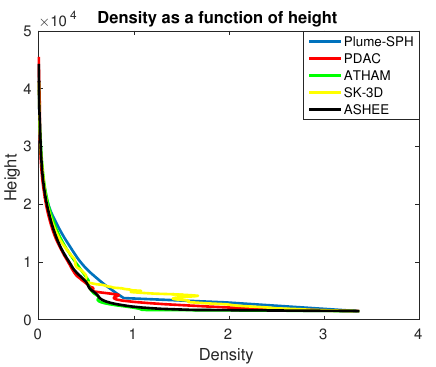
Figure 14. Radius of the strong plume without wind after reaching its top